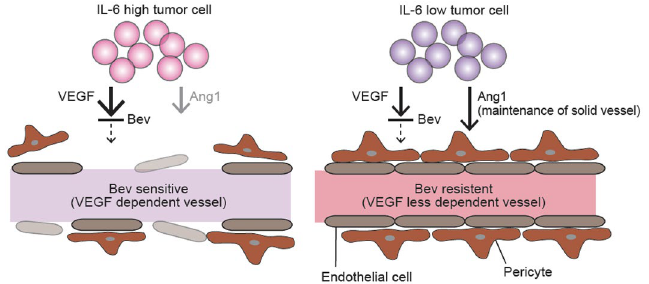
Figure 5. Mechanism of enhanced anti-angiogenic efficacy of Bev in IL-6 high tumor with Ang1 suppression. IL-6 supports the anti-angiogenic activity of Bev by suppressing Ang1 expression and promoting dependence on VEGF for angiogenesis. (This illustration is drawn by means of Adobe